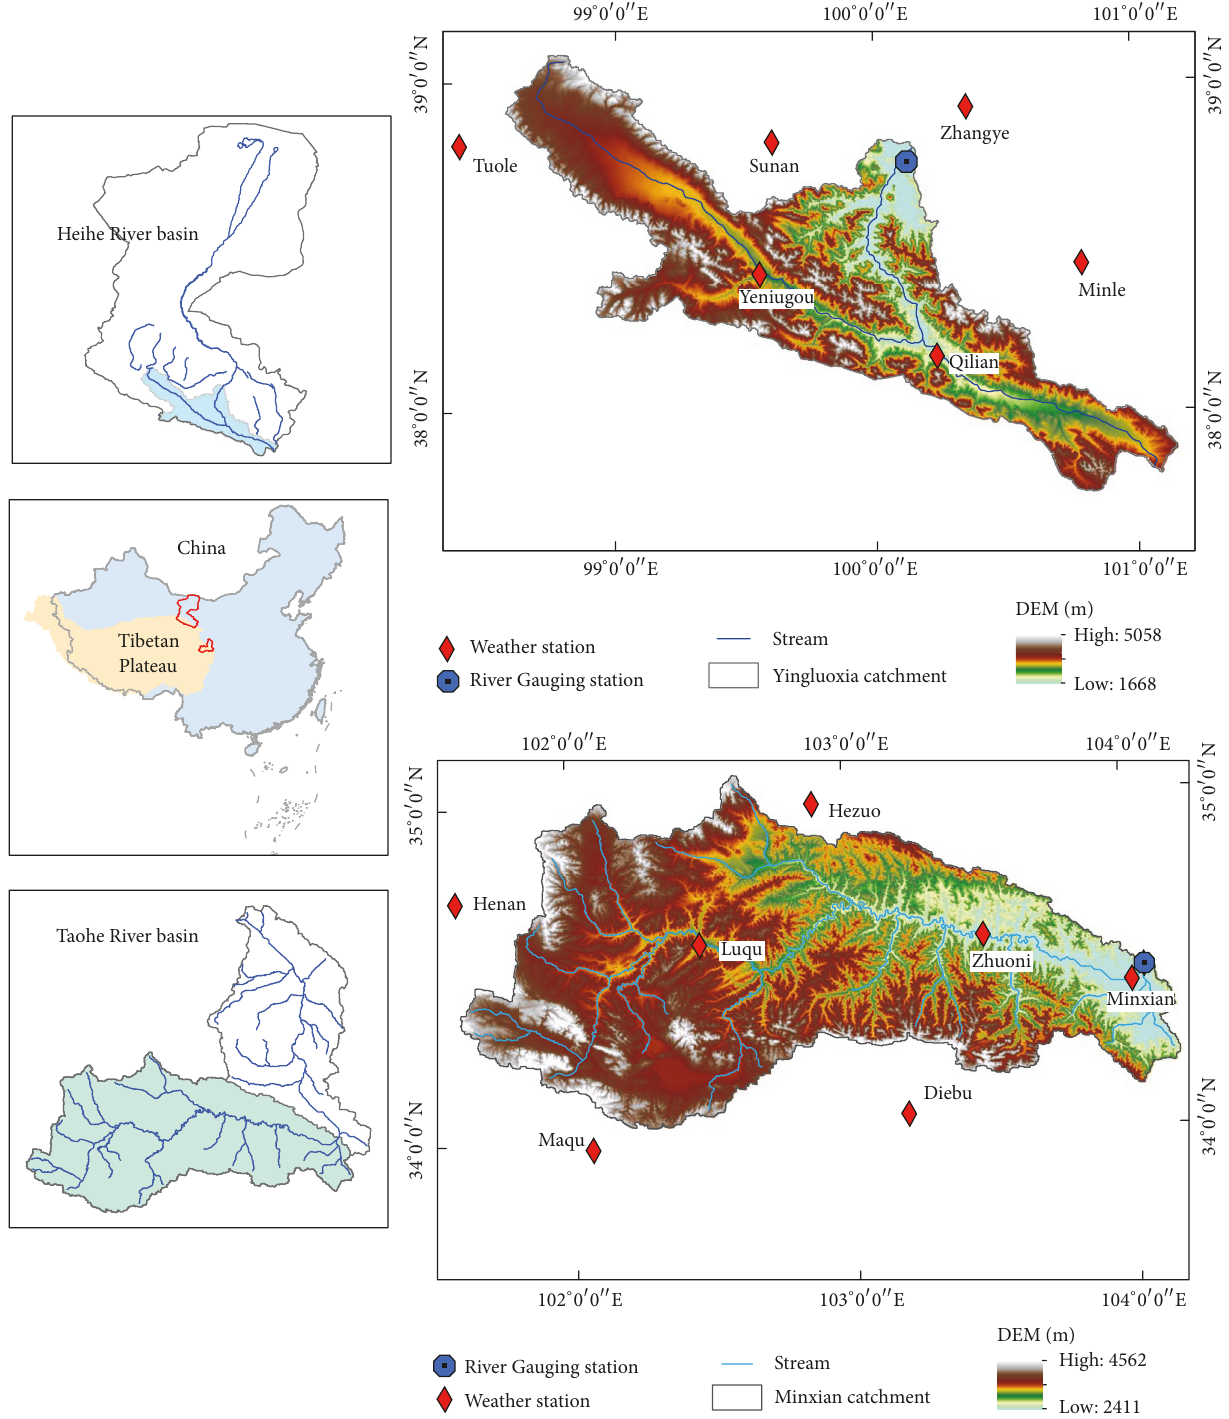
Figure 1: Location of Yingluoxia catchment (YLC) and Minxian catchment (MXC) together with distribution of digital elevation model and hydrometeorology